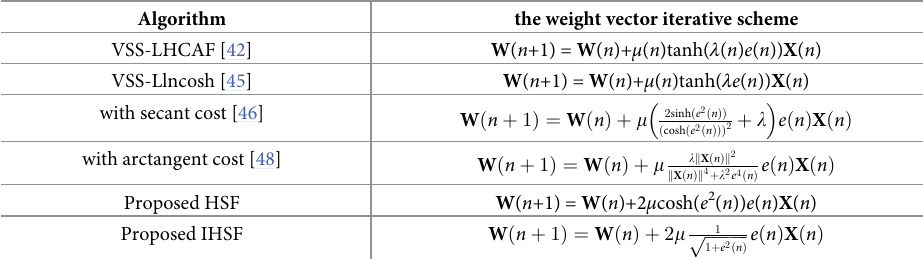
Table 1. The weight vector iterative scheme of adaptive filters by using the hyperbolic function.